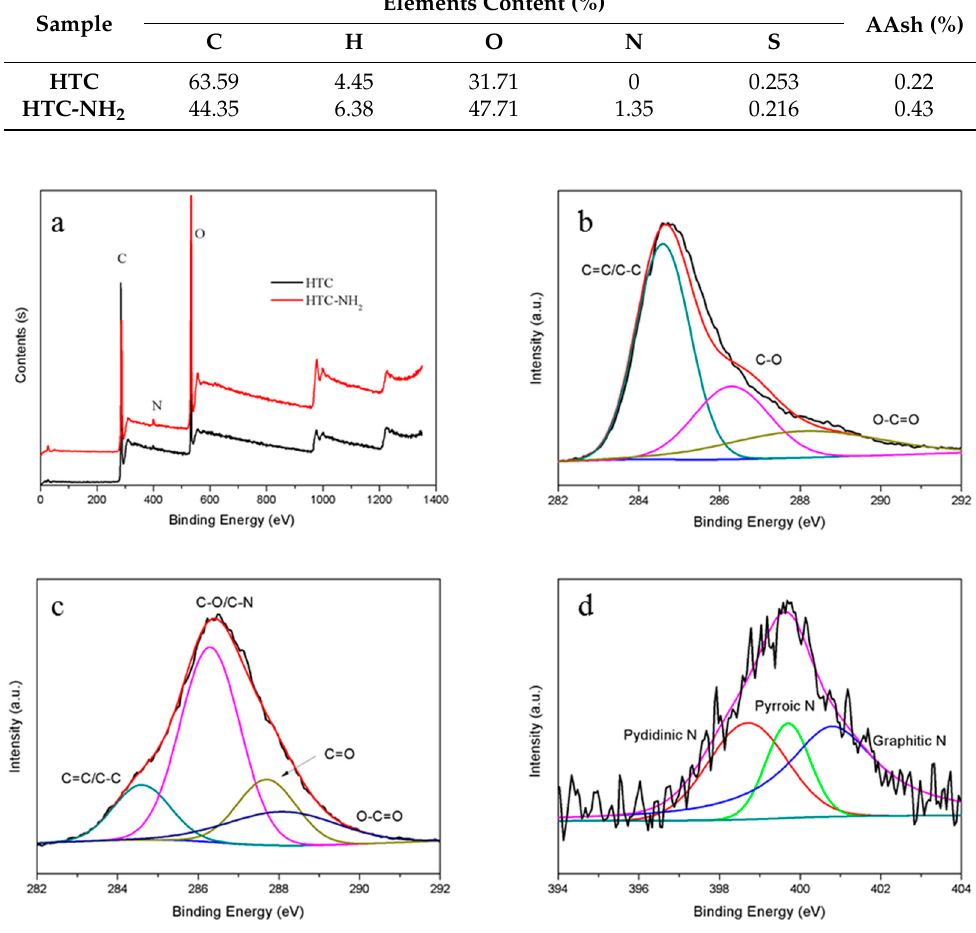
Figure 4. X-ray photoelectron spectroscope (XPS) spectra: ( a ) HTC and HTC-NH 2 ; ( b ) C 1s spectra of HTC; ( c ) C 1s spectra of HTC-NH 2 ; and ( d ) N 1s spectra of HTC-NH 2 .